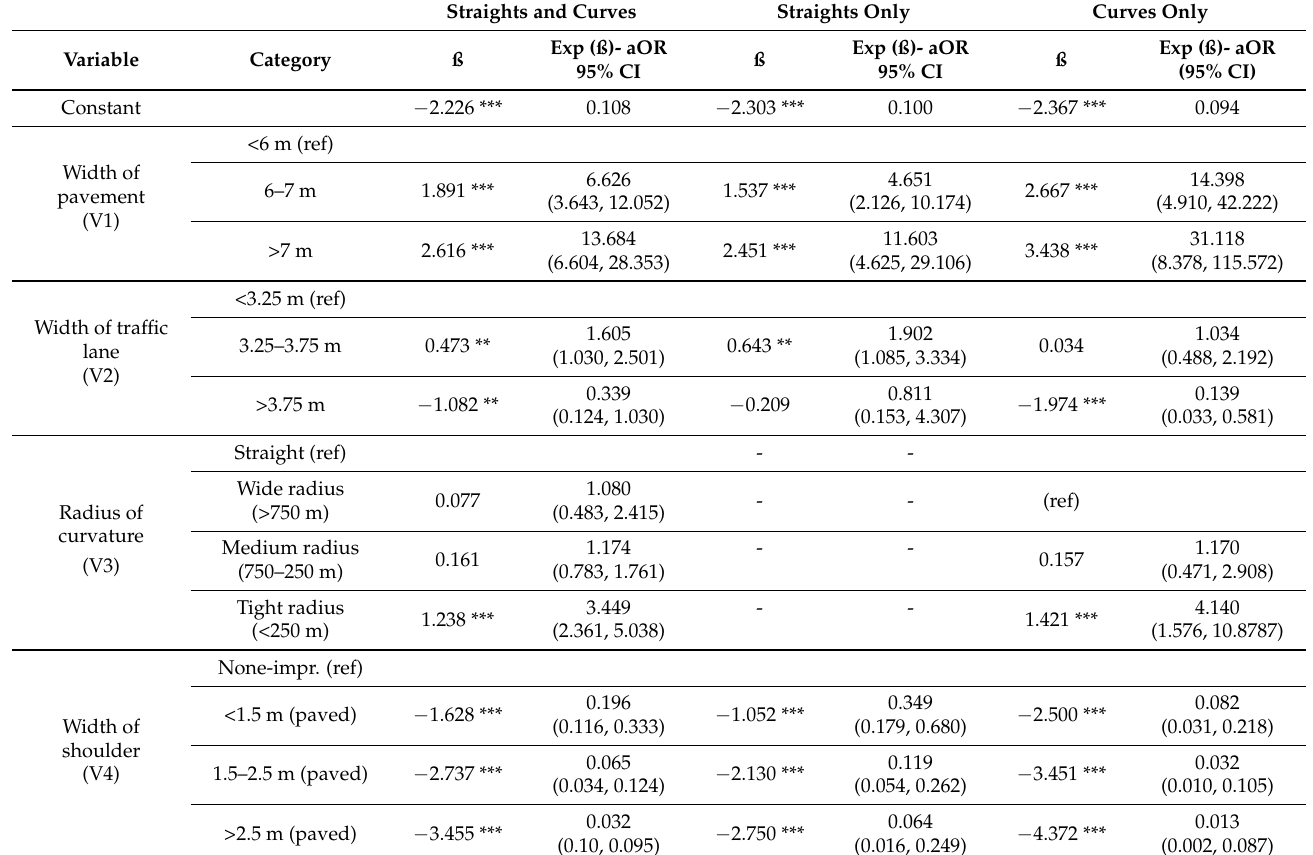
Table 4. Final models selected for each scenario, where ** stands for p -value ≤ 0.05 and *** for p -value ≤ 0.01. Straights and Curves Straights Only Curves Only